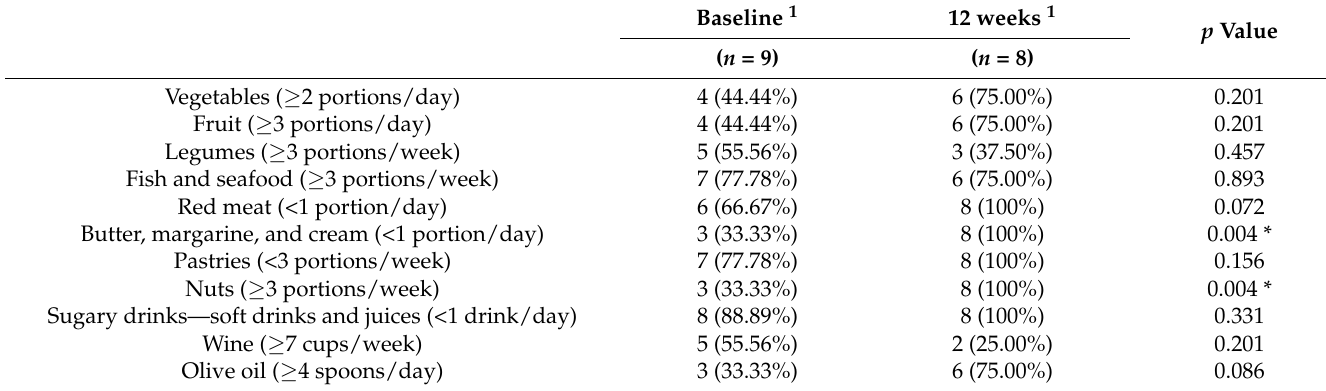
Figure 1. Adherence to the Mediterranean diet after 12 weeks. Low adherence—MEDAS score < 10; high adherence— MEDAS score ≥ 10 ( A ). Changes in HbA1c ( B ) and HOMA-IR ( C ) after 4 weeks and 12 weeks of the intervention. HbA1c—glycated hemoglobin; HOMA-IR—Homeostatic Model Assessment for Insulin Resistance. * Differences were considered statistically significant when p < 0.05 vs. baseline. Table 2. Food group consumption evaluated by MEDAS